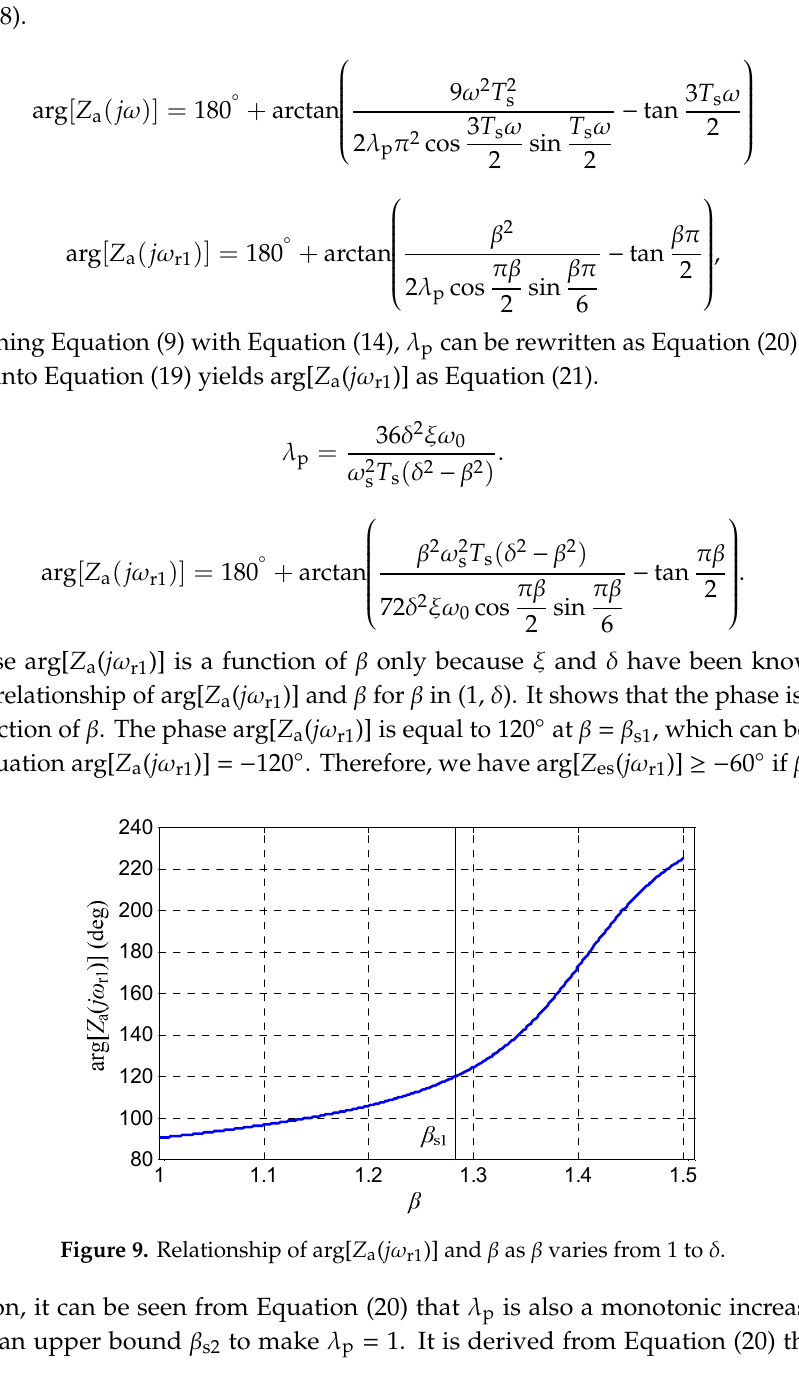
Figure 9. Relationship of arg[ Z a ( j ω r1 )] and β as β varies from 1 to δ .